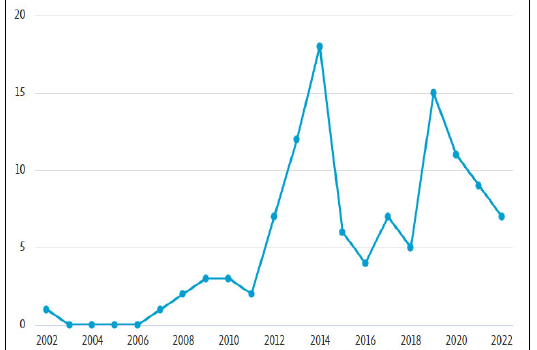
Fig. 2a. Biometric analysis of the words “Concrete”, “Pho- tocatalytic” and “Environmental” Source: Scopus scien- tific review. Source: Obtained from